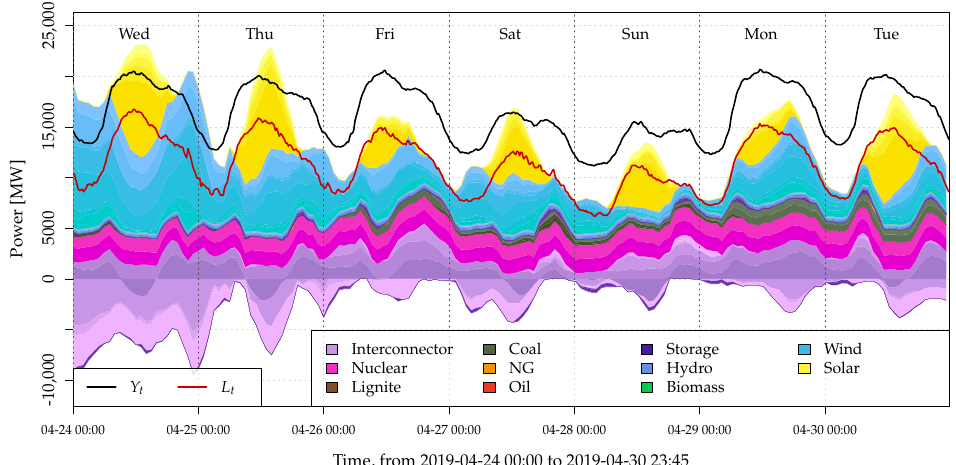
Figure 1. Time series plot of the load Y t and the process L t with its single components X G , i , t and X I , i , t classified by generation type in the last week of April